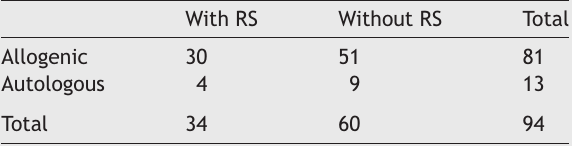
Frequency of hematologic diseases of the selected patients.